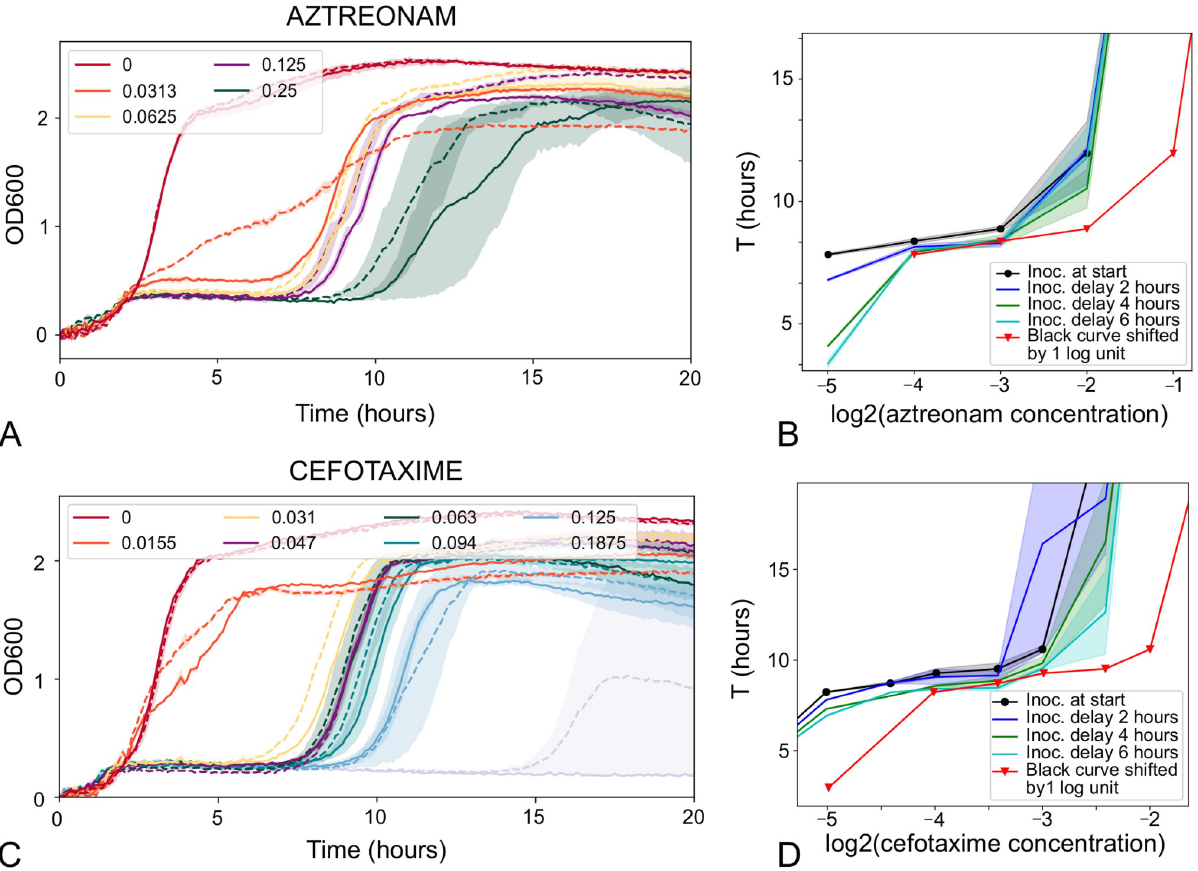
Fig 5. Aztreonam and cefotaxime have half-lives longer than 6 hours in MOPSgluRDM at pH 7.4 and 37˚C. A,B: Delay-time bioassay for aztreonam. A: Time-shifted growth curves. Solid lines show results for immediate inoculation; dashed lines are for inoculation with a 4 hour delay. The aztreonam concentrations are listed in the legend with units of μ g/ml. B: Analysis (plots of time to reach OD threshold of 0.75). The red curve shows the black curve (immediate inoculation) shifted by 1 log 2 unit. The blue curve corresponds to inoculation after a 2 hour delay, the green curve a 4 hour delay and the teal curve a 6 hour delay. Since the curves for delayed inoculation of 4h and 6h (green and teal curves) do not reach the red curve, the half- life is longer than 6 hours. C,D: Delay-time bioassay for cefotaxime. C: Time-shifted growth curves. Solid lines show results for immediate inoculation; dashed lines are for inoculation with a 2 hour delay. The cefotaxime concentrations are listed in the legend with units of μ g/ml. D: Analysis (plots of time to reach OD threshold of 0.75). The red curve shows the black curve (immediate inoculation) shifted by 1 log 2 unit. The blue curve corresponds to inoculation after a 2 hour delay, the green curve a 4 hour delay and the teal curve a 6 hour delay. Since the curves for delayed inoculation of 4h and 6h (green and teal curves) do not reach the red curve, the half-life is longer than 6 hours.